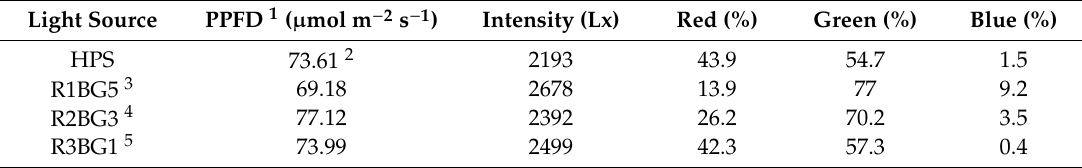
Table 1. Lighting conditions ( ≈ 45 cm beneath the lighting source) from high pressure sodium (HPS) lamps and the three types of light-emitting diodes (LEDs) for the culture of Korean pine ( Pinus koraiensis ) seedlings.